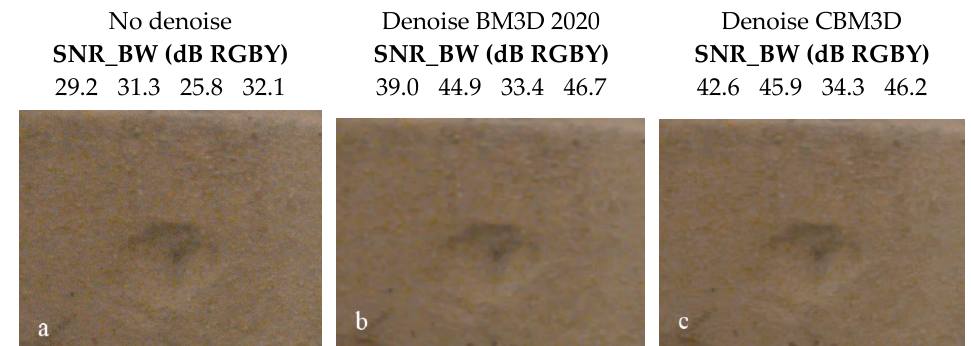
Figure 20. Subjects for the testing phase: ( a ) Hercules; ( b ) Porcupinefish; ( c ) Horn d’Arturo Globe; ( d ) Marsili bust. Each case study is represented with its bounding box and diagonal D (see intrinsic feature). The diagrams at the bottom repre- sent the general features of each object (see Figure 21).